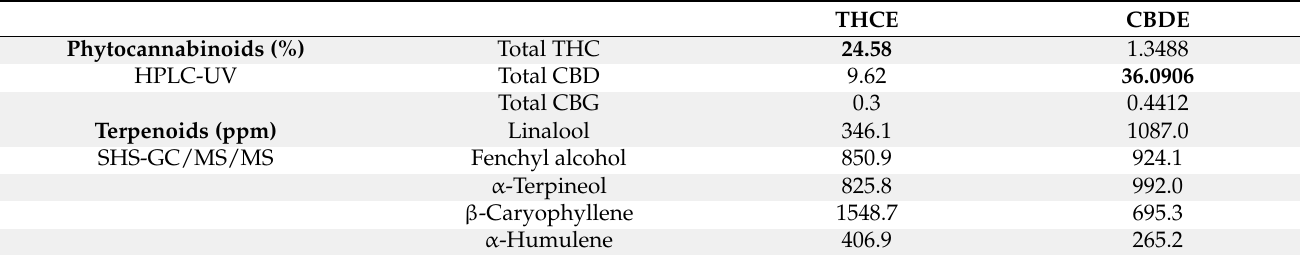
Table 1. Chemical analysis of the main phytocannabinoids and terpenoids in the cannabis extracts. THCE CBDE Phytocannabinoids (%) Total THC 24.58 1.3488 HPLC-UV Total CBD 9.62 36.0906 Total CBG 0.3 0.4412 Terpenoids (ppm) Linalool 346.1 1087.0 SHS-GC/MS/MS Fenchyl